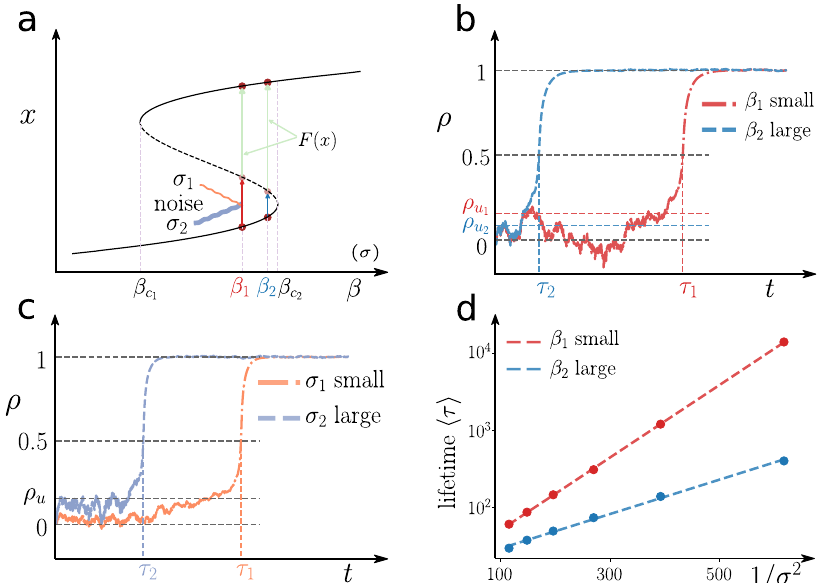
; β Þ , there Fig. 1 The transition in the single-variable system. a The resilience function of a general bistable system. For the bifurcation parameter β 2 ð β c 1 c 2 are two stable states ( x L , x H ) and one unstable state ( x u ). The initial stable state ( x L ) evolves to the unstable state ( x u ) by the aid of noise and is then naturally attracted to the other stable state ( x H ) by its deterministic dynamics. b and c display the evolution of the rescaled state ρ in the presence of noise. The time to transition (measured by the lifetime of the initial state), τ , changes with the system parameter β and noise strength σ (de fi ned by the standard deviation of Gaussian noise). b As β 2 is closer to the critical value β than β 1 , the unstable state ρ is lower, making the barrier in the landscape easier to c 2 u 2 cross in the presence of the same strength of fl uctuations, and the lifetime τ 2 is thus smaller than τ 1 . c The parameter β is the same, leading to the same landscape. In the presence of stronger noise σ 2 , it is easier to drive the system to get over the barrier, causing τ 2 to be smaller than τ 1 . d shows the simulation results of the average lifetime 〈 τ 〉 under different values of β and different noise strengths. The dashed line is fi tted based on Eq.